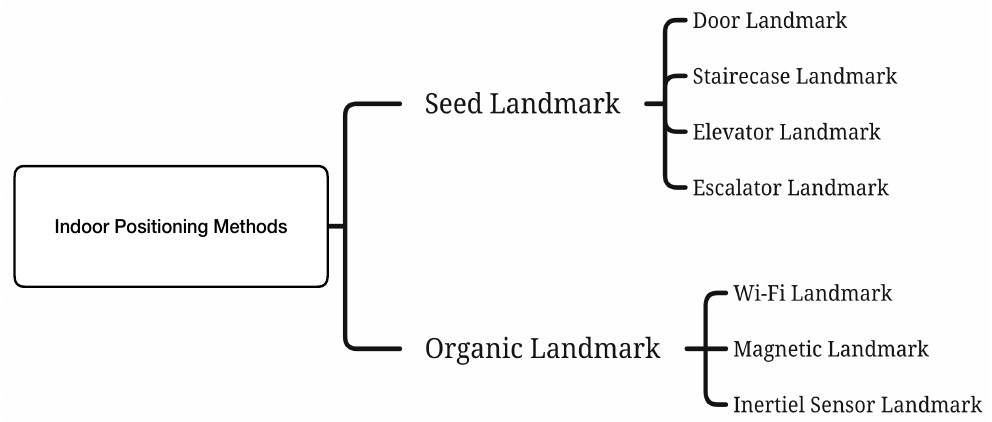
Figure 8. Types of landmarks, reprinted from